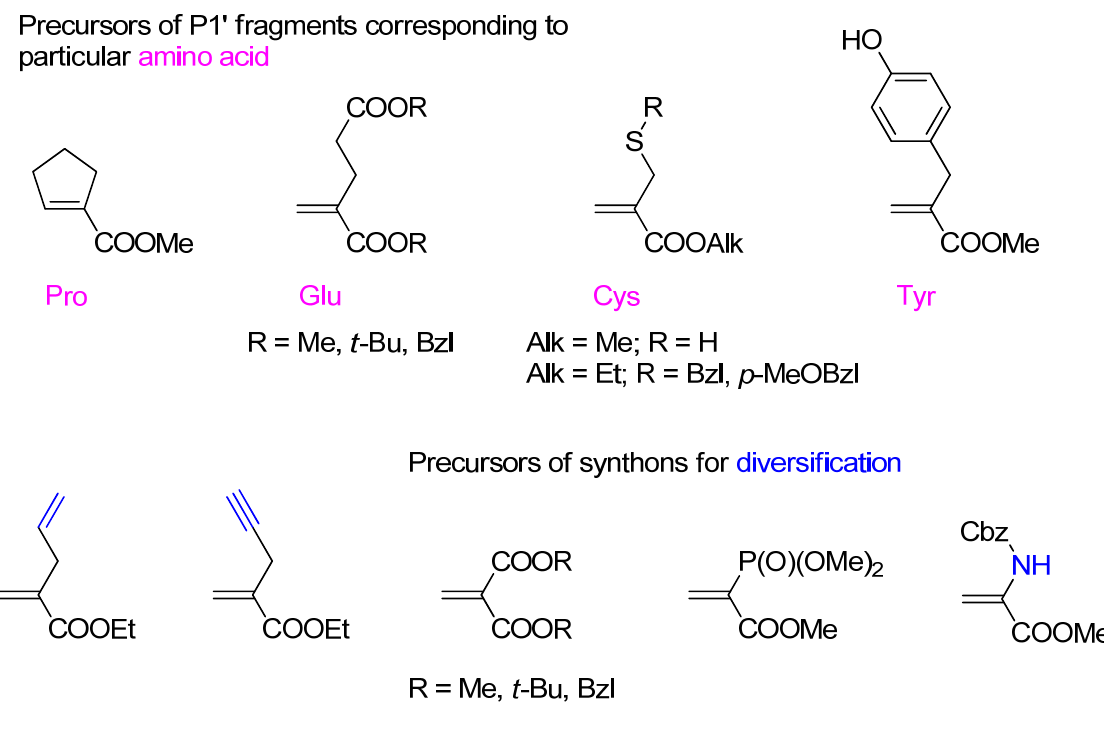
Figure 2. A selection of additionally functionalized α -substituted acrylate derivatives that were found to be compatible with phospha-Michael addition